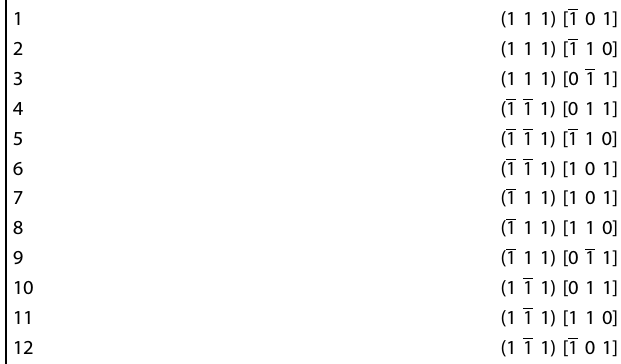
Table 5. FCC Slip